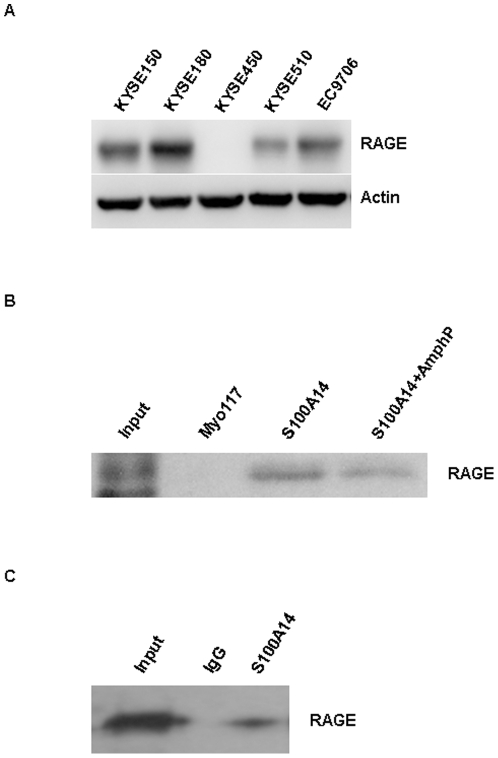
The interaction of S100A14 with RAGE.(A) Western blot showed the endogenous RAGE expression in ESCC cell lines. (B) KYSE180 cell lysates were incubated with exogenous S100A14 and His-resin. RAGE was identified in the immunoprecipitates by Western blot with an anti-RAGE antibody. KYSE180 cell lysates were used as a control. Myo117 protein was added as a negative control. Preincubation with AmphP (5 µM) for 1 h interfered with the interaction of S100A14 and RAGE. (C) KYSE180 cell lysates were immunoprecipitated with anti-S100A14 polyclonal antibodies and RAGE was identified in the immunoprecipitates by Western blotting.